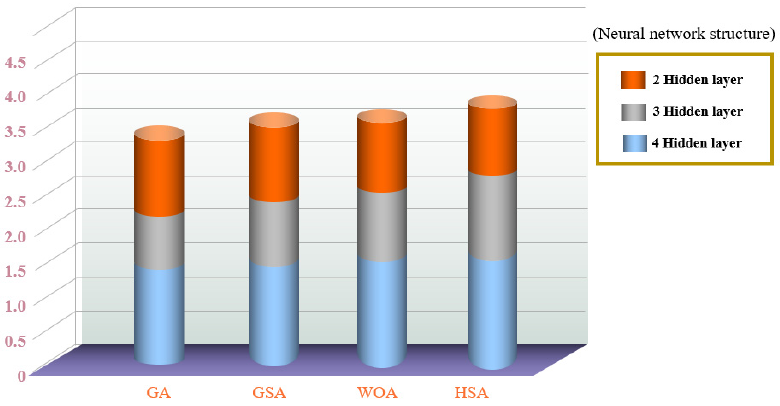
Figure 23. RMSE errors for two-hidden-layer and three-hidden-layer networks.